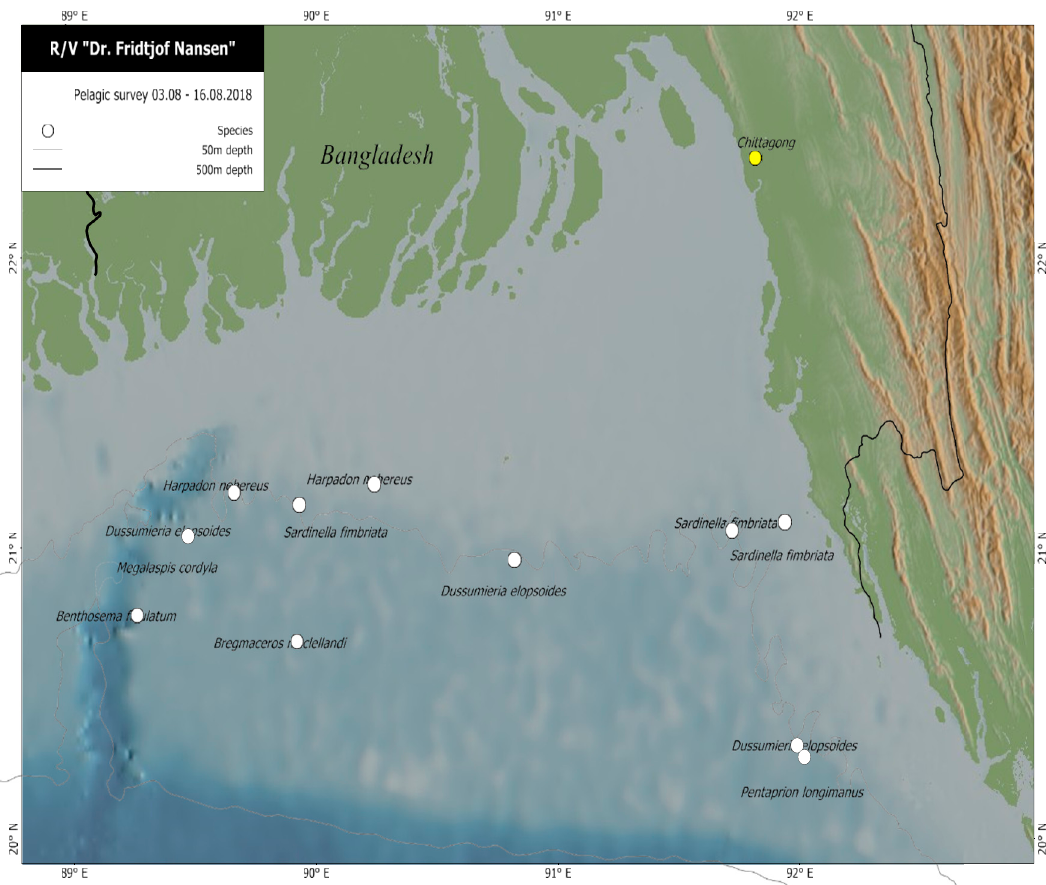
Figure 1. Sampling locations of the included fish species during the 2018 Nansen survey in Bangladesh, the Bay of Bengal .